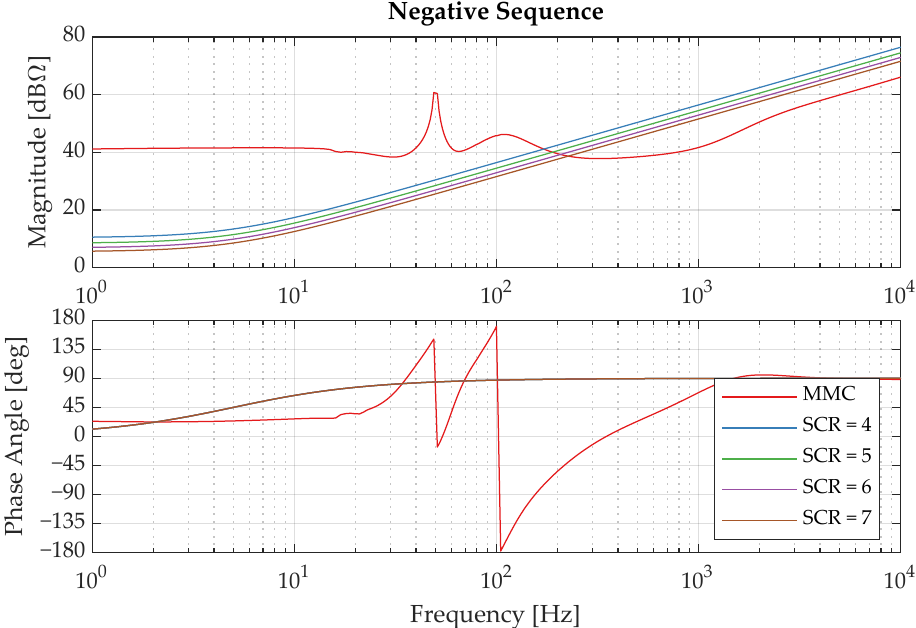
Figure 8. MMC impedance and AC grid impedance for different SCRs. Figure 9 show a close-up of the Bode plots around the intersection frequencies for the different SCRs. Marking the magnitudes and phase angles at f PM , they reveal that for a SCR = 4, the phase difference exceeds 180° for the positive-sequence